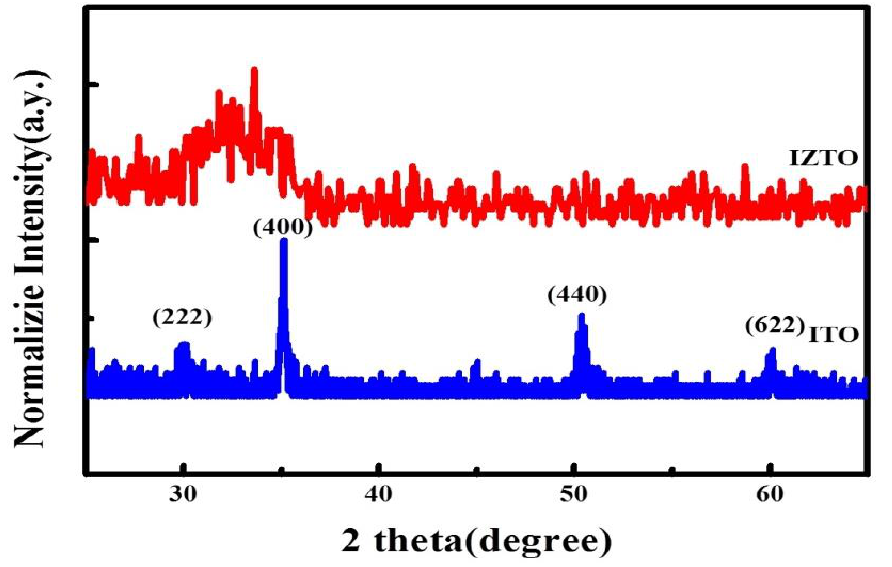
Figure 2. The XRD patterns of the different TCO films.